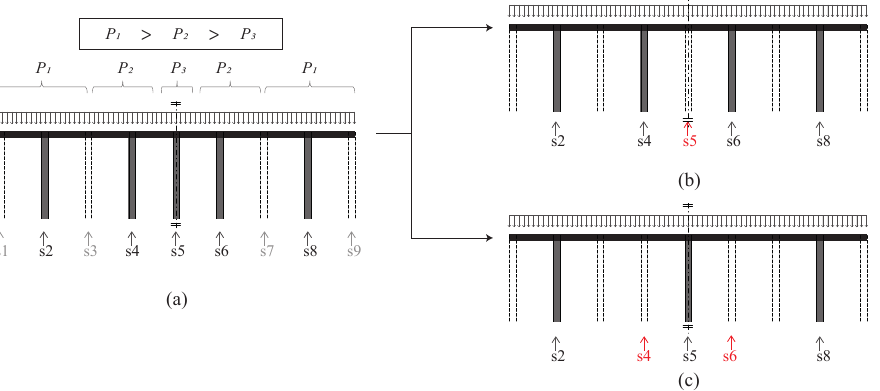
Figure 3. Controlling optimization tendency with filter utilization. ( a ) Intermediate state of optimiza- tion process. Optimization result generated ( b ) without a filter and ( c ) with a